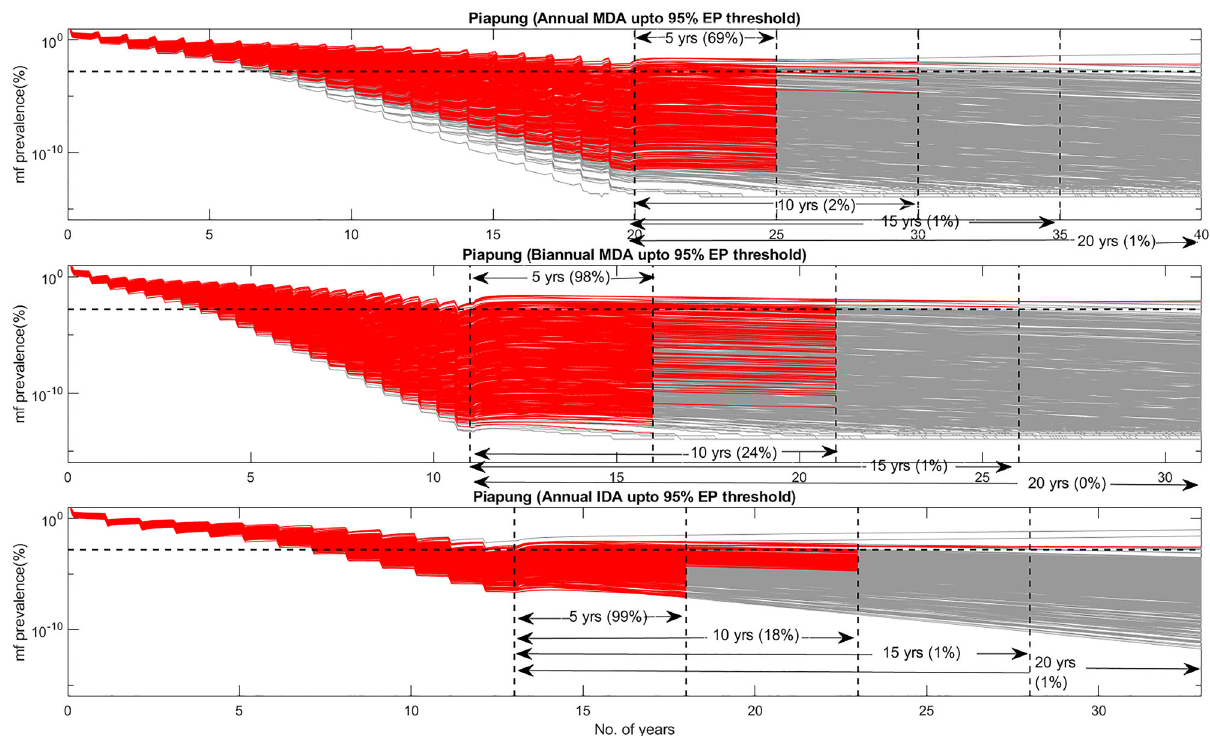
Fig. 5 Predicted transient dynamics in mf prevalence using annual MDA, biannual MDA, and annual IDA and the 95% mf prevalence EP threshold for Piapung. Red curves indicate the model fi ts with transient behavior (curves having no signi fi cant positive or negative slopes) whereas the gray curves indicate the model fi ts having signi fi cant positive or negative slopes for different time periods (5, 10, 15, and 20 years) after stopping MDA following breaching of the 95% EP mf threshold. The fi gures in percentage show the percentage of the curves describing transient